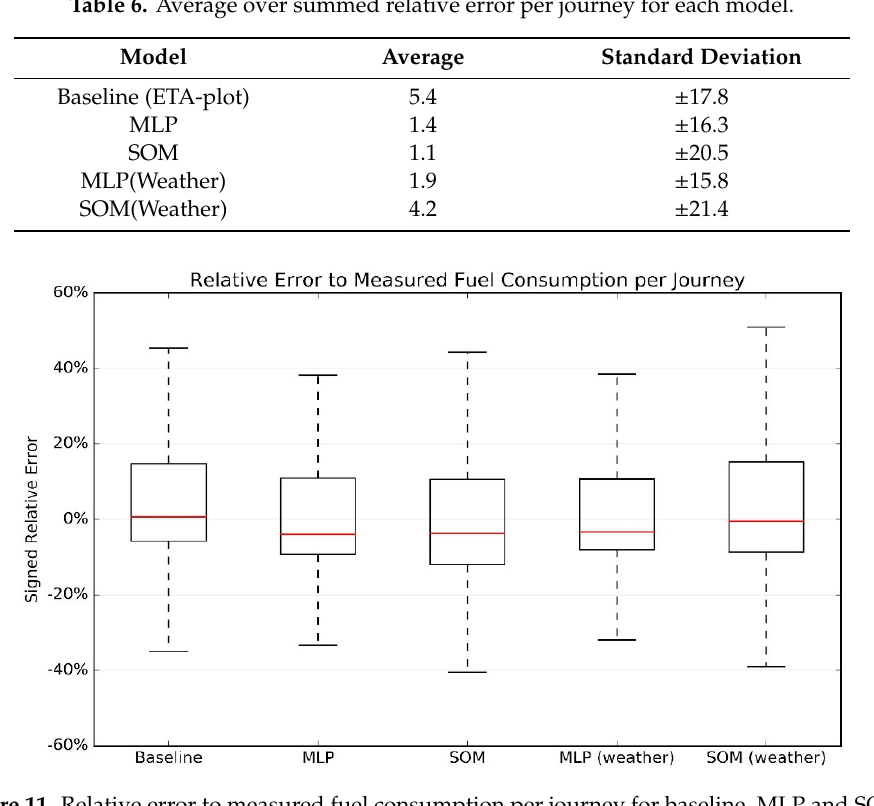
Figure 11. Relative error to measured fuel consumption per journey for baseline, MLP and SOM.